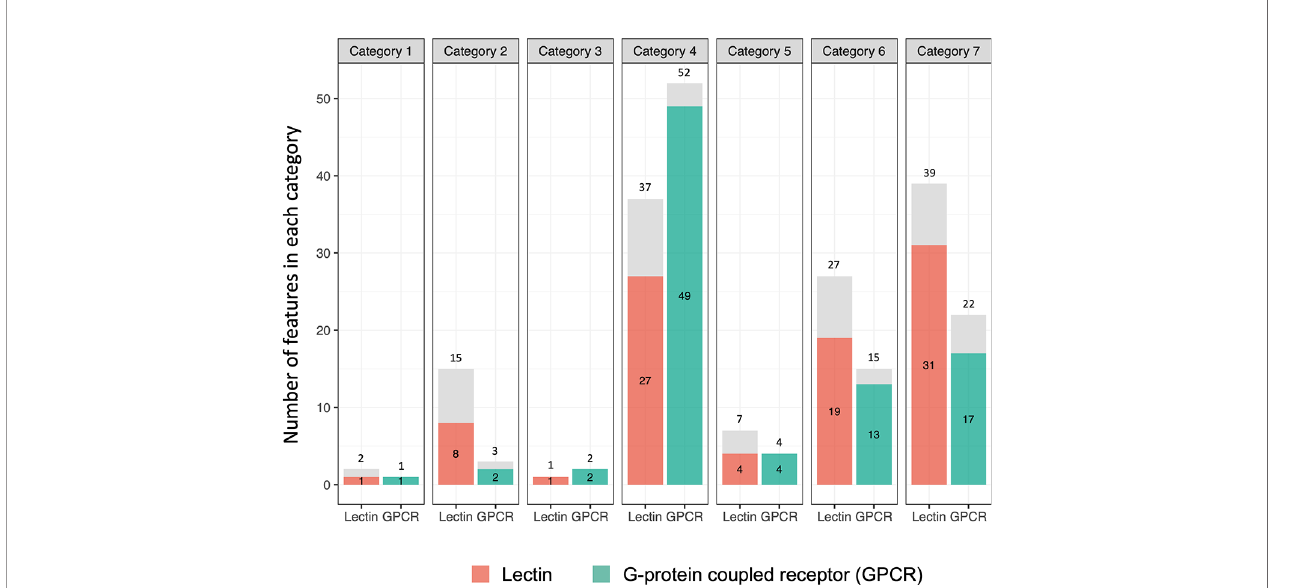
FIGURE 9 | Bar graph showing numbers of lectin and G-protein coupled receptor (GPCR) genes in the 7 categories. The number outside of each bar is the total number of genes observed. The number inside the bar is the number of genes seen unique to that category (highlighted in orange or green